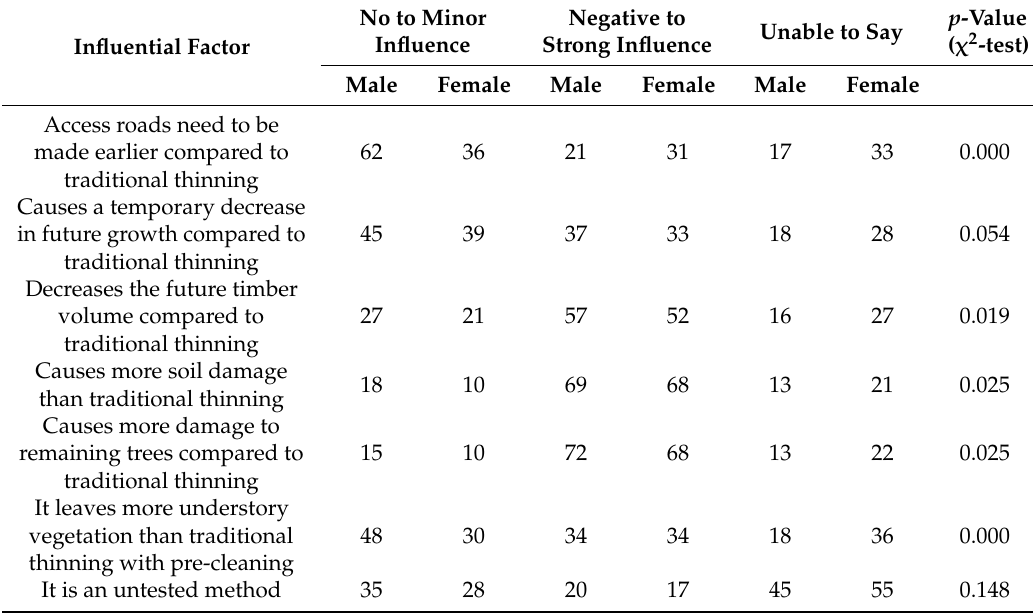
Table 12. Distribution (%) of male and female forest owners’ perception of how various hypothetical disadvantages associated with whole-tree harvesting in early thinnings would a ff ect their attitude towards the